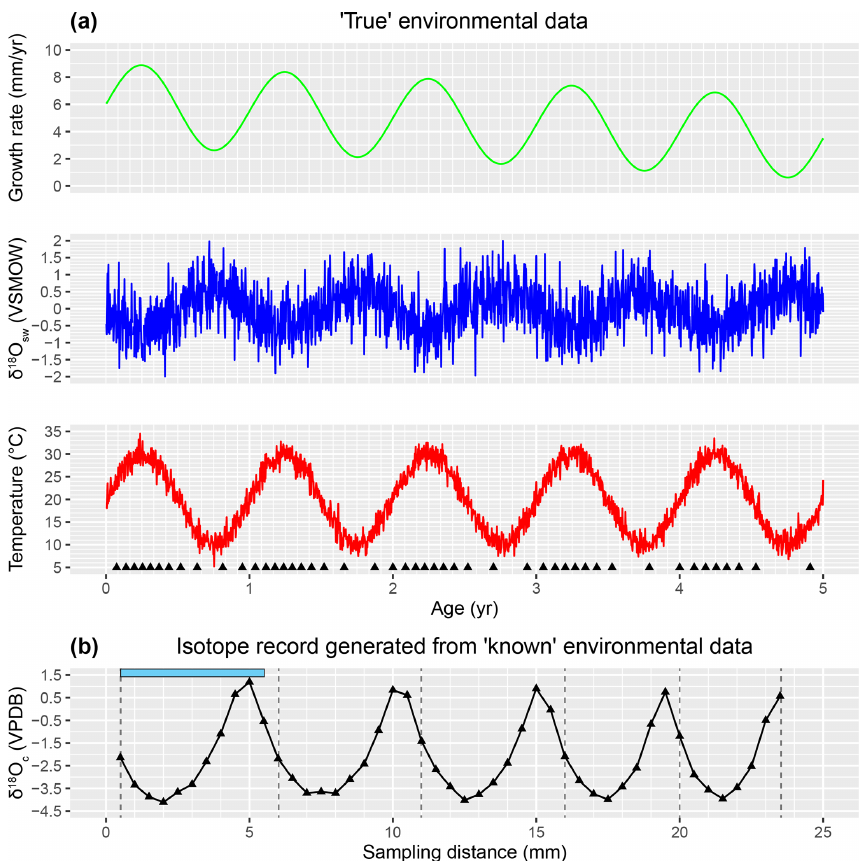
Figure 2. (a) Plots of the growth rate (light green), δ 18 O w (blue), and temperature (red) records (in time domain) from which the test case was produced. Black triangles on the bottom of the temperature plot indicate the ages of the samples taken from the record. (b) The δ 18 O c record for the test case generated after equidistant sampling using the seasonalclumped package (de Winter et al., 2021a) with a sampling interval of 0.5mm. Error bars on sampling distance (0.1mm) and δ 18 O c (0.1‰) fall within the symbols. Vertical grey dashed lines indicate user-provided year markers, and the blue bar on top of this plot shows an example of the width of a modeling window. See the Supplement for details on producing the test case δ 18 O c record and SI3 for the R script used to generate the